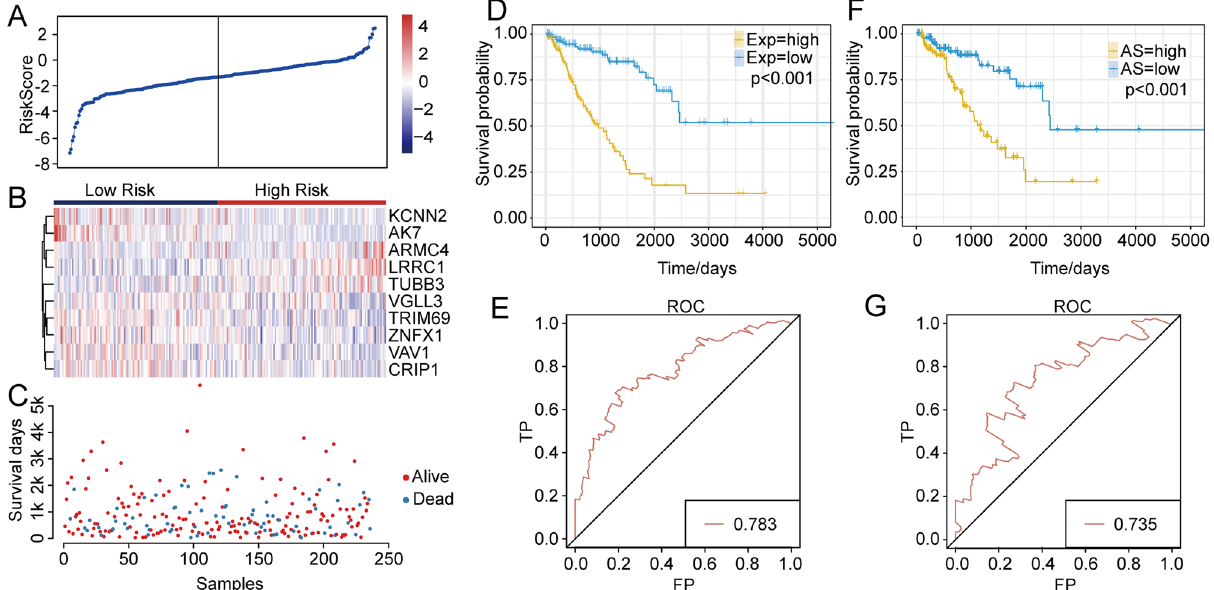
Figure 5. AS gene-related risk scores and survival analyses. ( A ) Risk-score analysis of the sarcoma samples. ( B ) The gene expression heat map for the ten hub genes. Gene expression differences were significant between the high- and low-risk groups. ( C ) Relationship between survival time and survival status for each sarcoma sample. ( D ) Kaplan–Meier curves for overall survival and transcriptome gene expression levels. ( E ) Area-under-the- curve (AUC) multifactorial survival analysis related to overall patient survival based on gene expression at the transcriptome level. ( F ) Kaplan–Meier curves for overall survival and AS genes. ( G ) AUC multifactorial analysis of AS gene overall survival related to patient